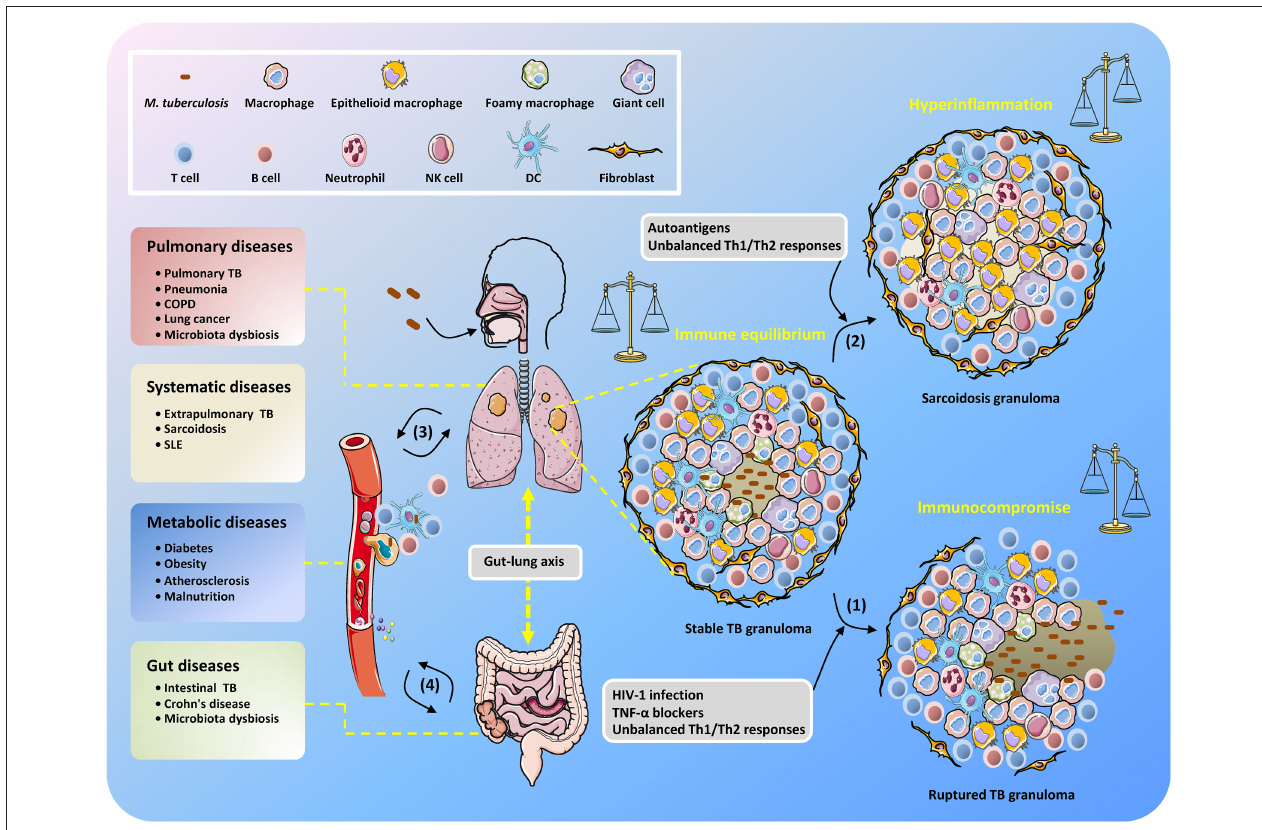
FIGURE 1 | Unbalanced immune system in TB patients results in the development of diverse diseases . After inhalation of M. tuberculosis , granulomas are formed with piles of immune cells to sequester the uncleared bacteria that subsequently step into latency. When the host becomes immunocompromised, M. tuberculosis is reactivated to replicate and disseminate, which is accompanied by granuloma caseating, liquefying, and cavitating (1). Non-caseating granulomas may continously exist after bacteria elimination and present as sarcoidosis because of excessive host inflammatory immune responses (2). The infected cells, M. tuberculosis conponents, metabolites, and host immune molecules such as cytokines and chemokines are able to be exchanged and transmitted via the circulatory system, thus increasing the risk of disease development (3). The gut microbiota is also involved in the interplay between M. tuberculosis and TB comorbidity via the gut-lung axis (4).